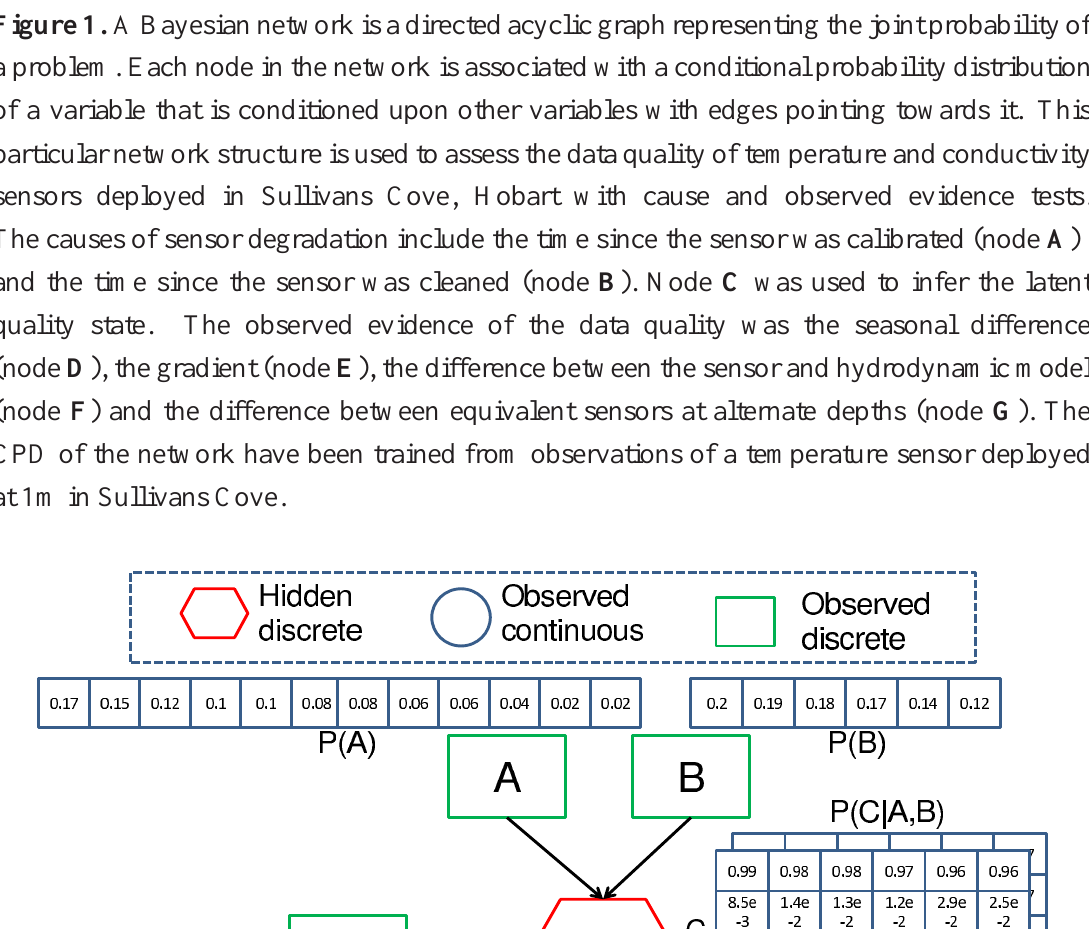
Figure 1. A Bayesian network is a directed acyclic graph representing the joint probability